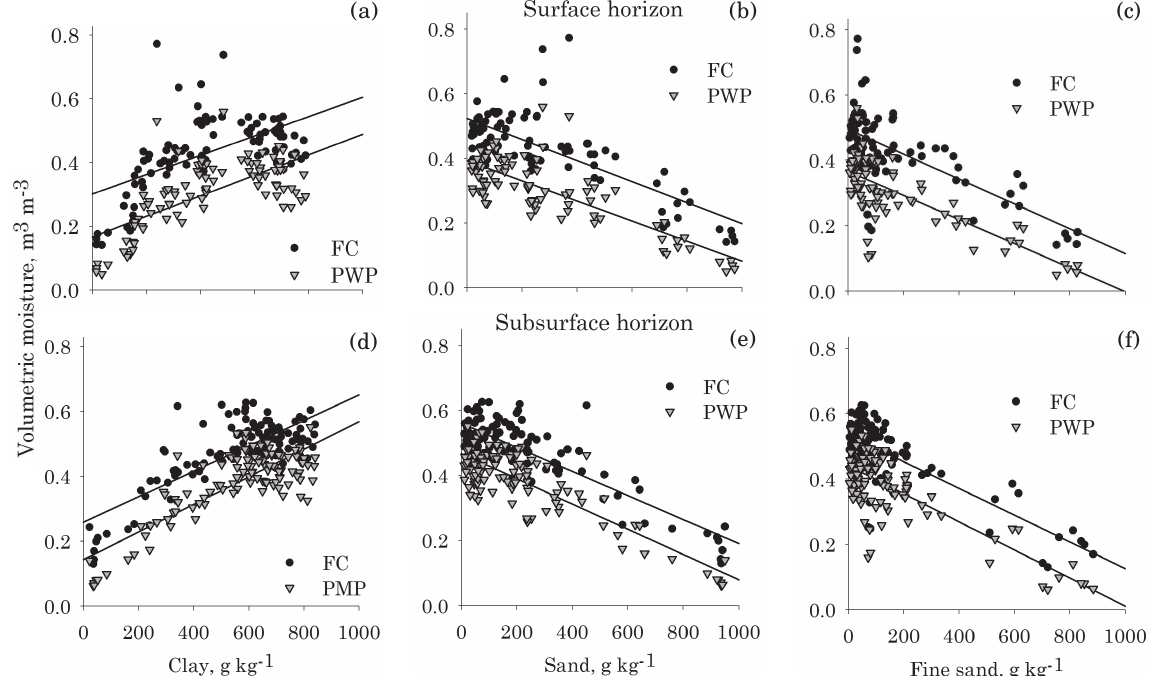
Figure 1. Scatter plots of field capacity (FC) and permanent wilting point (PWP) versus the clay, total sand and fine sand contents in the surface (a, b, c) and subsurface (d, e, f) horizons of soils in the State of Santa Catarina.